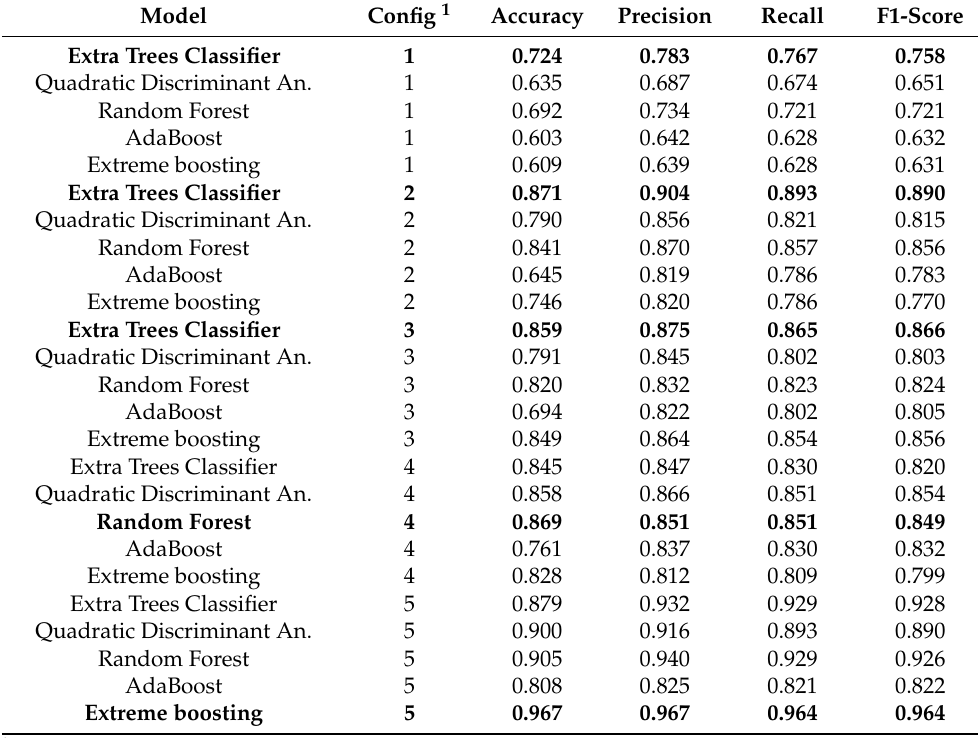
Table 5. Classifier performance diagnostics for models trained using different parameter configura- tions (Config column). All metrics were calculated using the measurements test set.